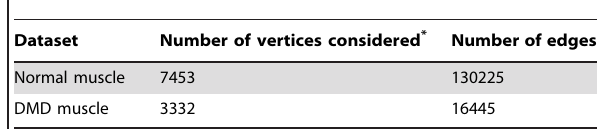
Table 1. Summary of interaction networks for normal and DMD muscle.